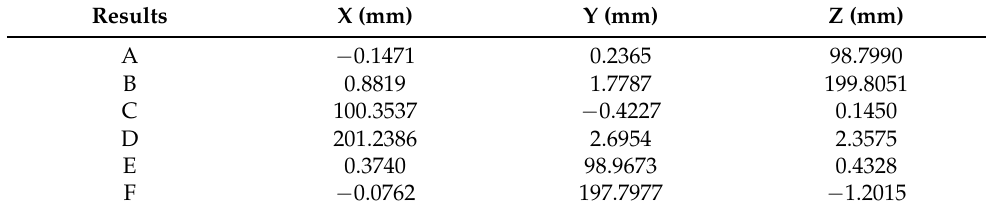
Table 15. Result of space points coordinates.